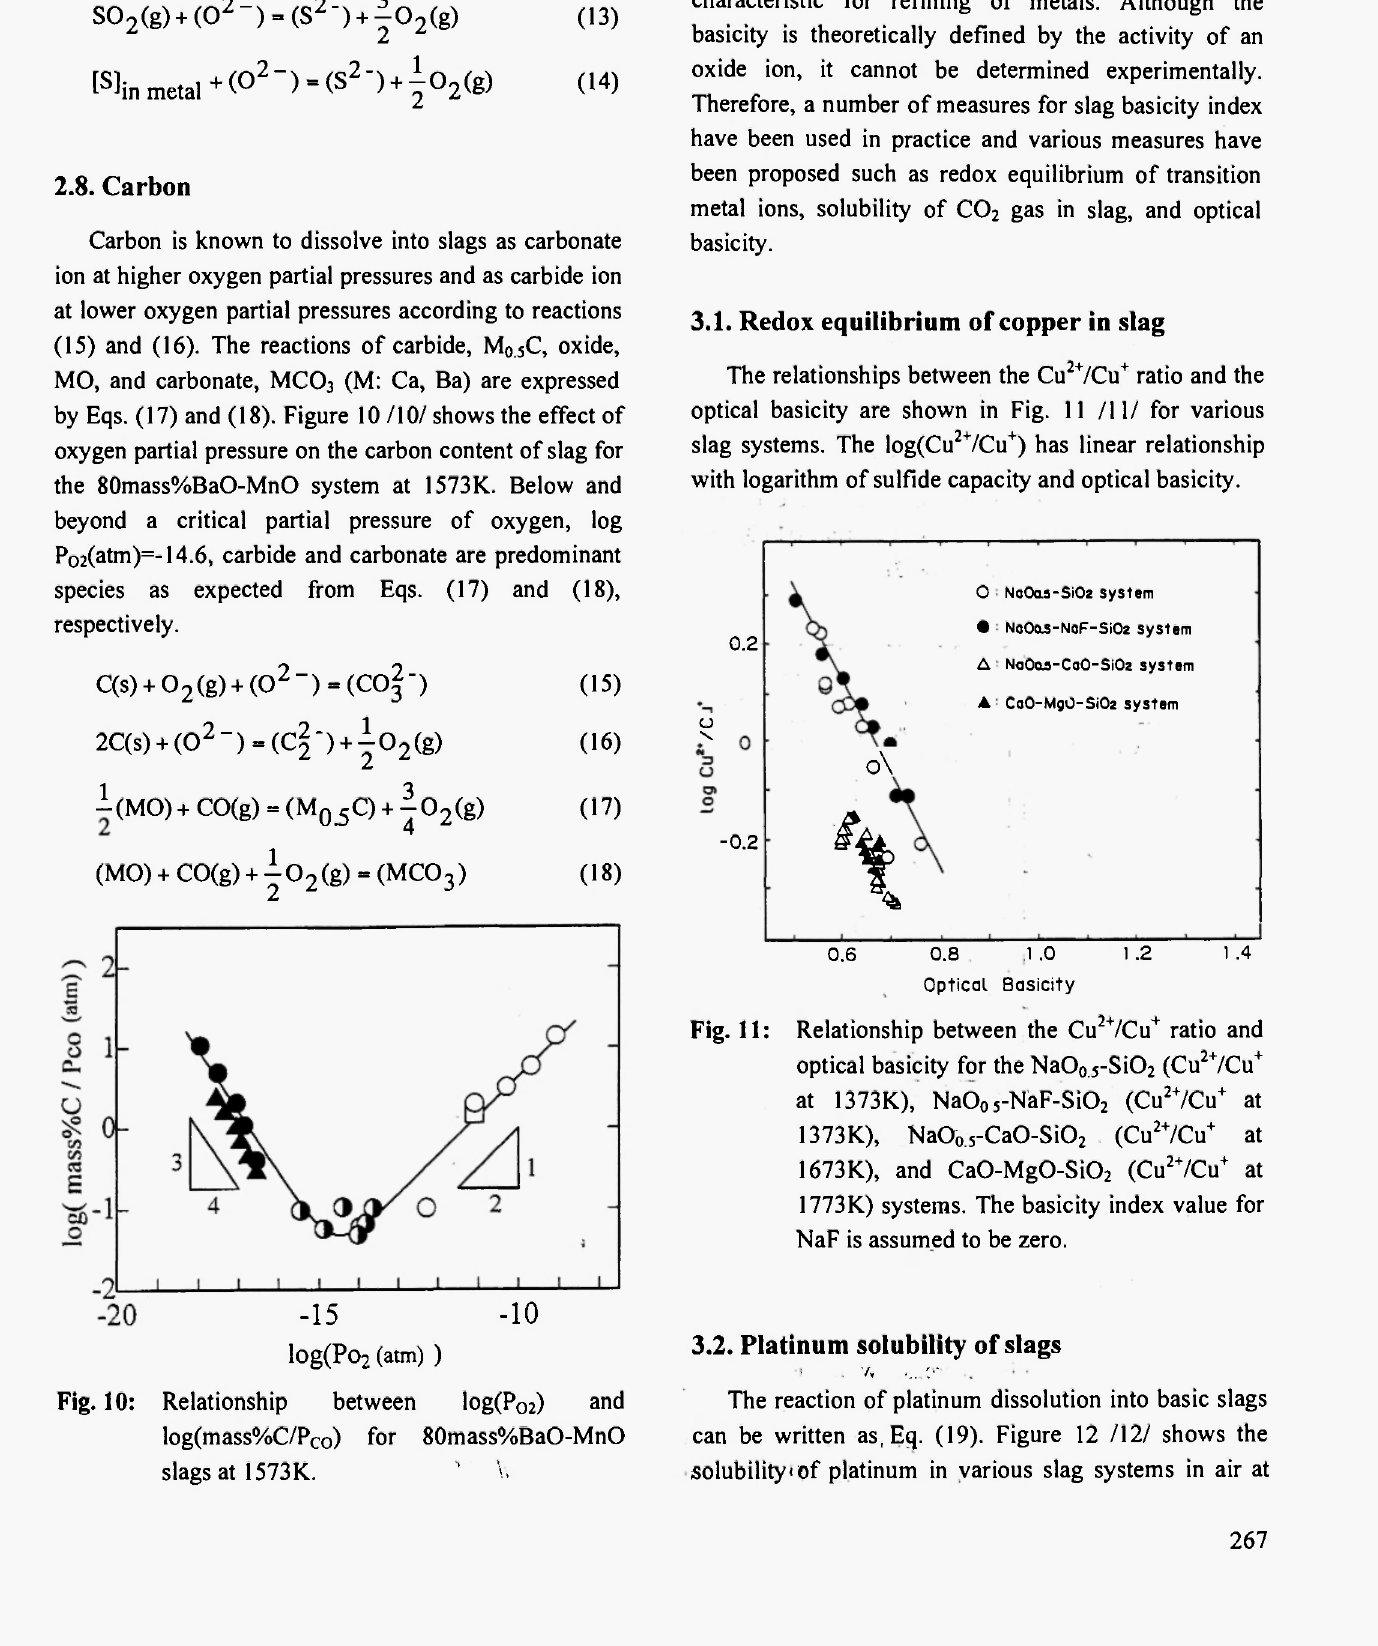
1673K), and Ca0-Mg0-Si0 2 (Cu 2+ /Cu +